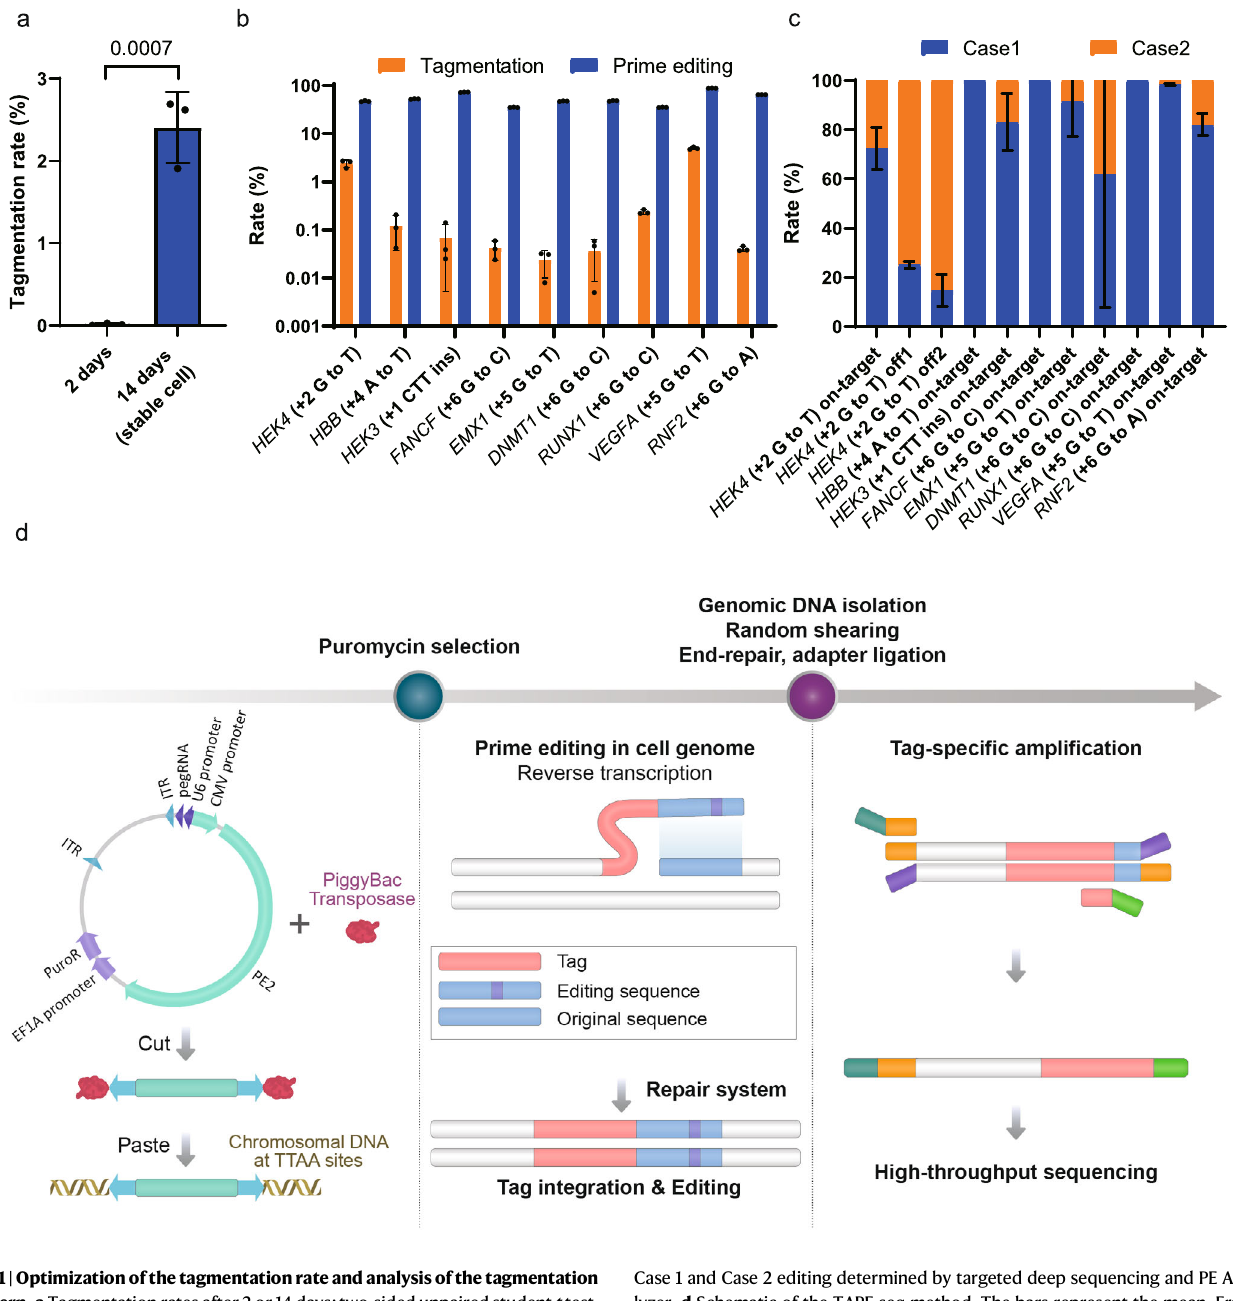
Fig.1|Optimizationofthetagmentationrateandanalysisofthetagmentation pattern.a Tagmentationratesafter2or14days;two-sidedunpairedstudent t test. b Tagmentationandprimeeditingratesatninedifferenton-targetsites. c